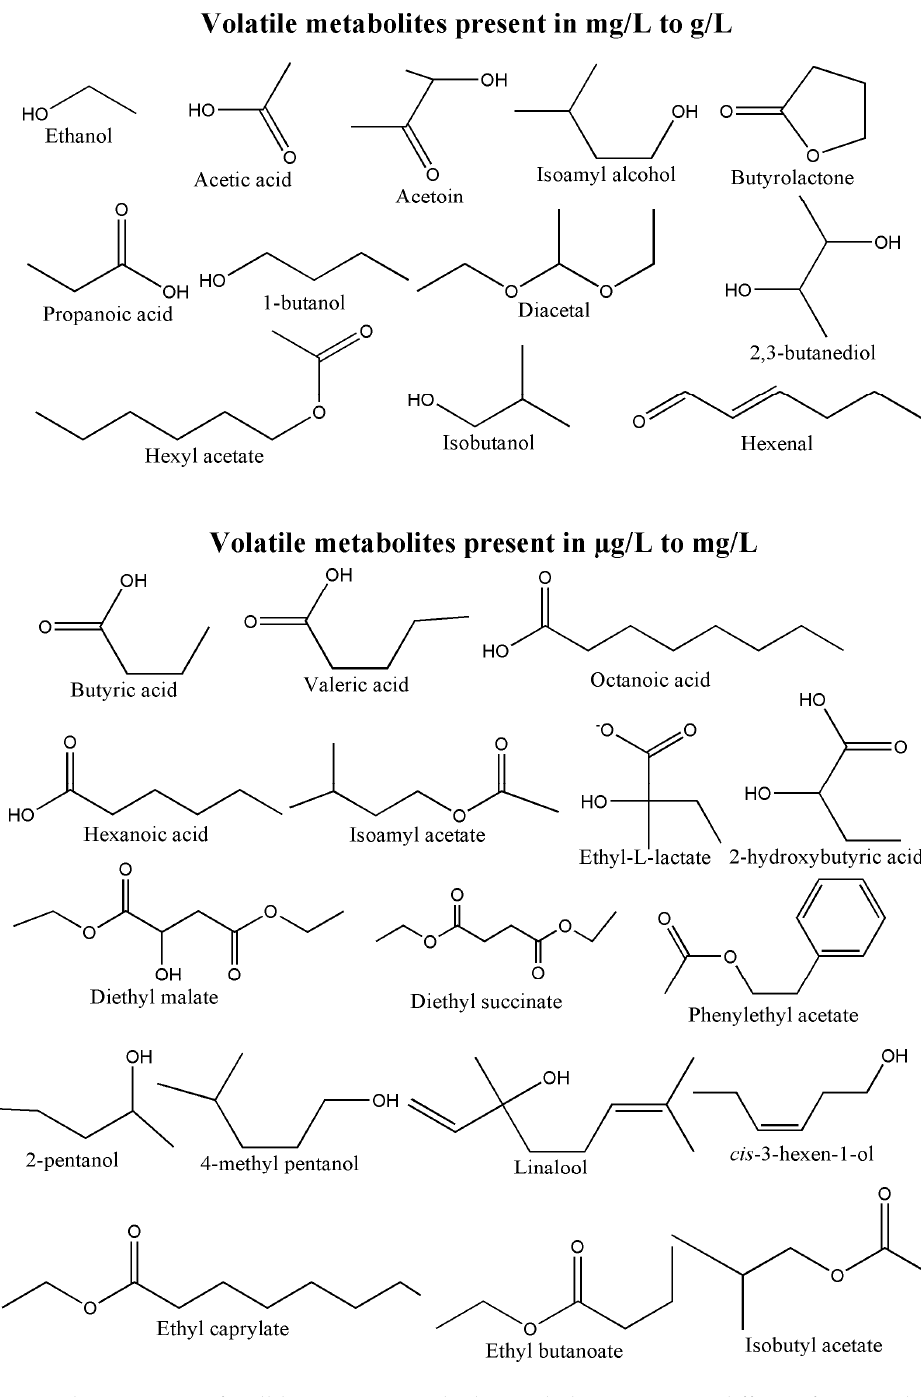
Figure 1. The structures ofwell-knownmajor volatile metabolites present in different fermented food and